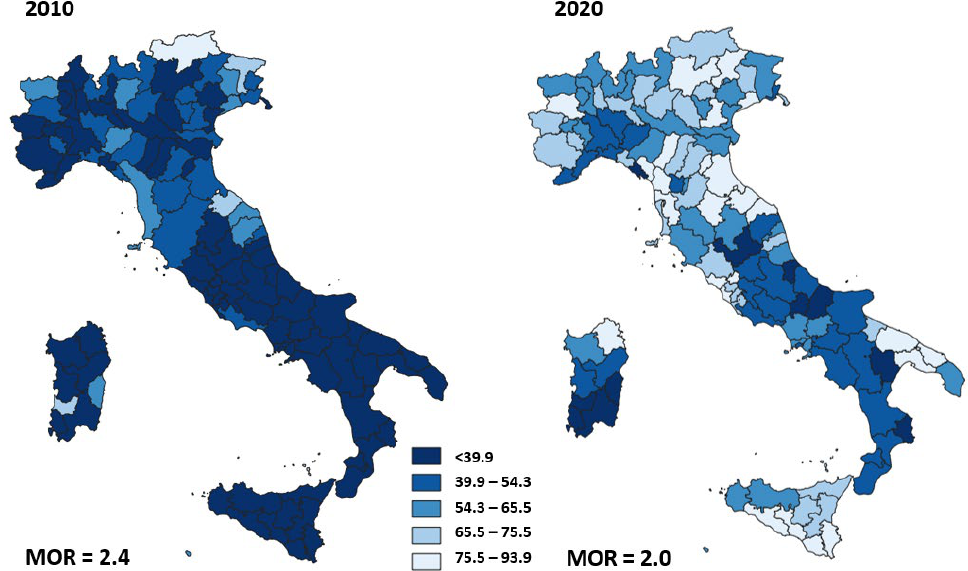
Figure 2. Adjusted proportion of surgery within 2 days after hip fracture in patients over 65 years of age, for Italian area of residence in 2010 and 2020.